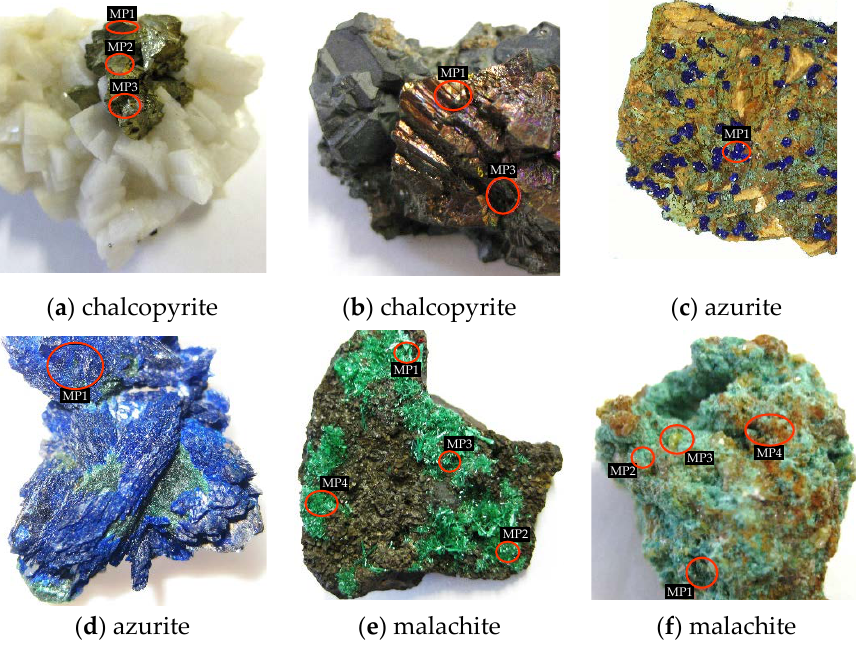
Figure 1. Examples of mineral distribution on the rock samples.